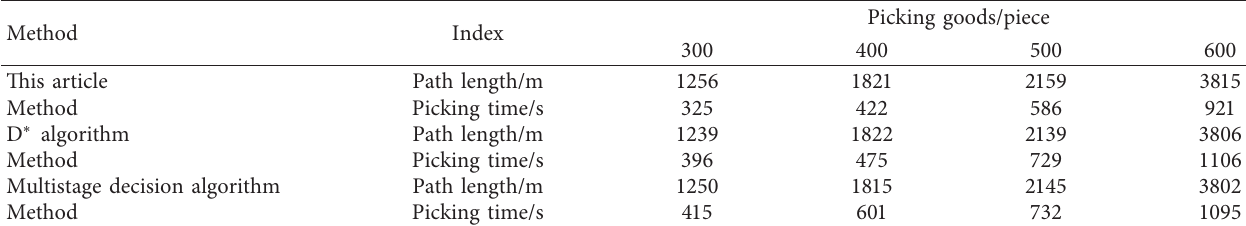
Figure 9: Comparison of the path planning results of the three methods. (a) D ∗ algorithm and method path planning results. (b) Multistage decision algorithm and method path planning results. (c) Path planning results of the method in this study. Table 1: Comparison of planning performance of 3